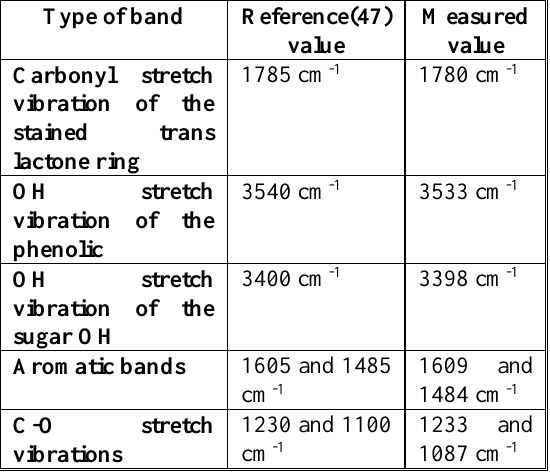
Table(4)FTIR bands for reference teniposide and